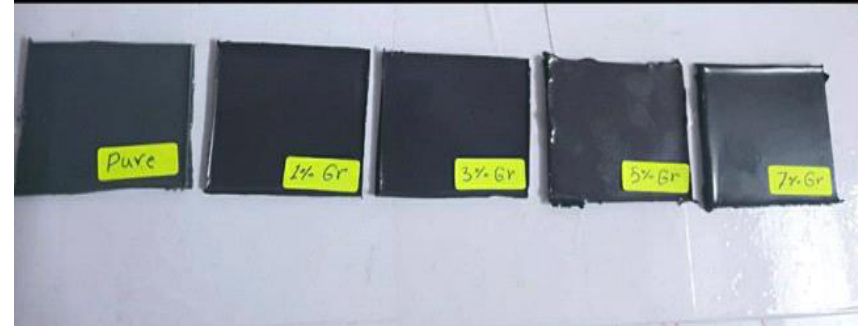
Figure 2: The samples blend /